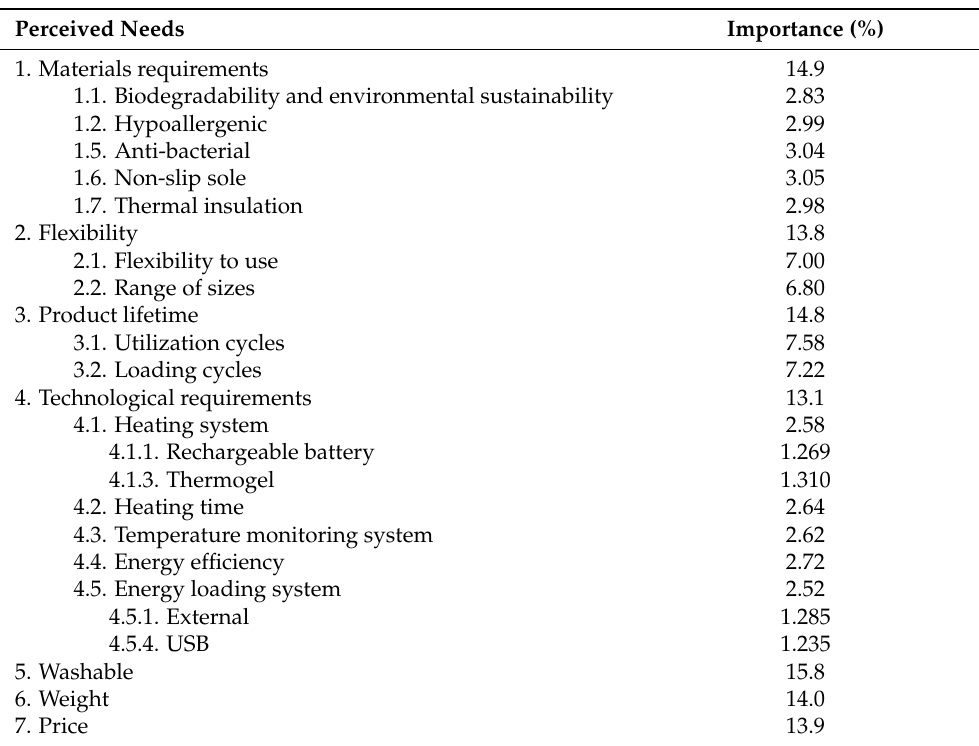
Table 4. Perceived needs hierarchically organized by